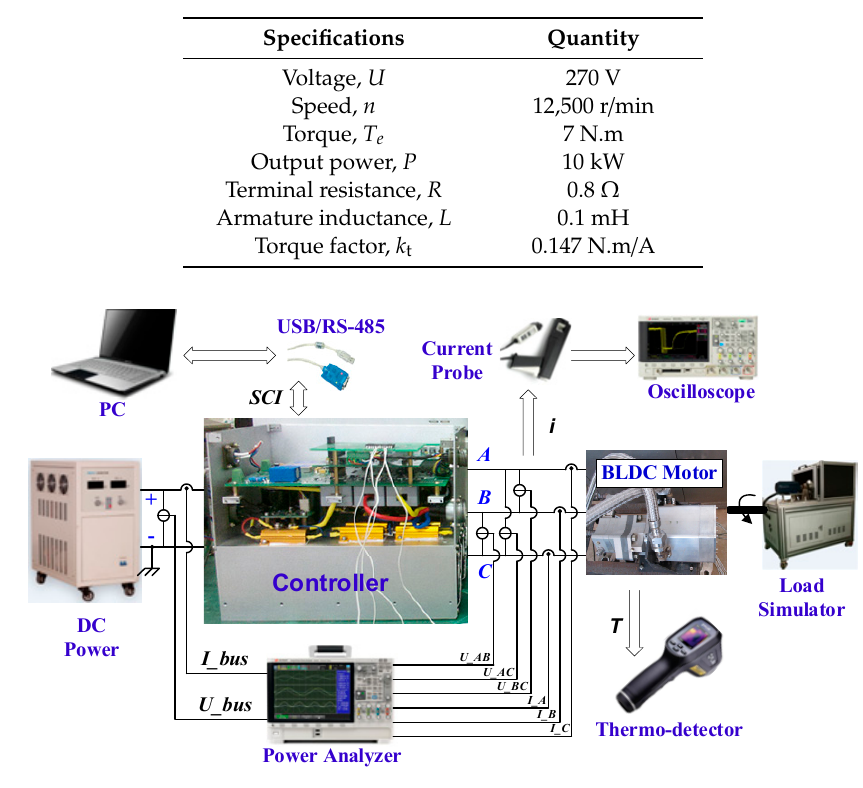
u _bus i _A Figure 11. Bus-voltage and phase-current waveforms in transient process. ( a ) Normal mode ; ( b ) manual boost mode ( K 1 = 1).